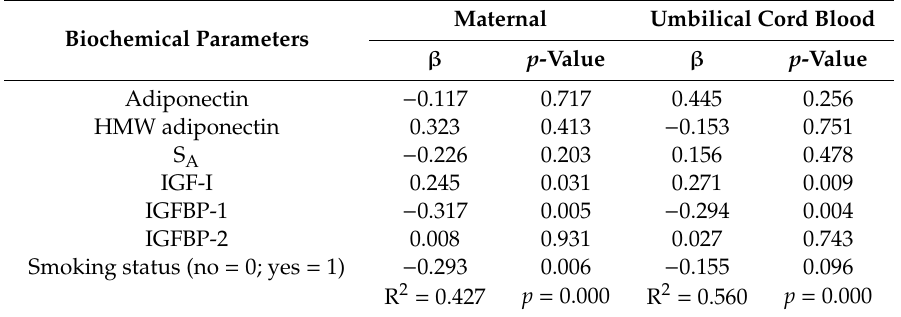
Table 5. Estimated β -coe ffi cients for the studied biochemical parameter levels in multivariate linear regression models explaining birth weight variability in the studied matched maternal-cord